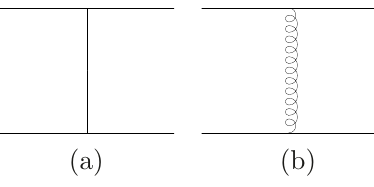
Figure 2 . Diagrams contributing to ( q ⊥ ) at LO. As shown in detail in appendix A, curly lines C soft are the A i gauge fields, solid lines are the electrostatic scalars A 0 . The parallel lines represent the Wilson line along the x + direction separated by x ⊥ .